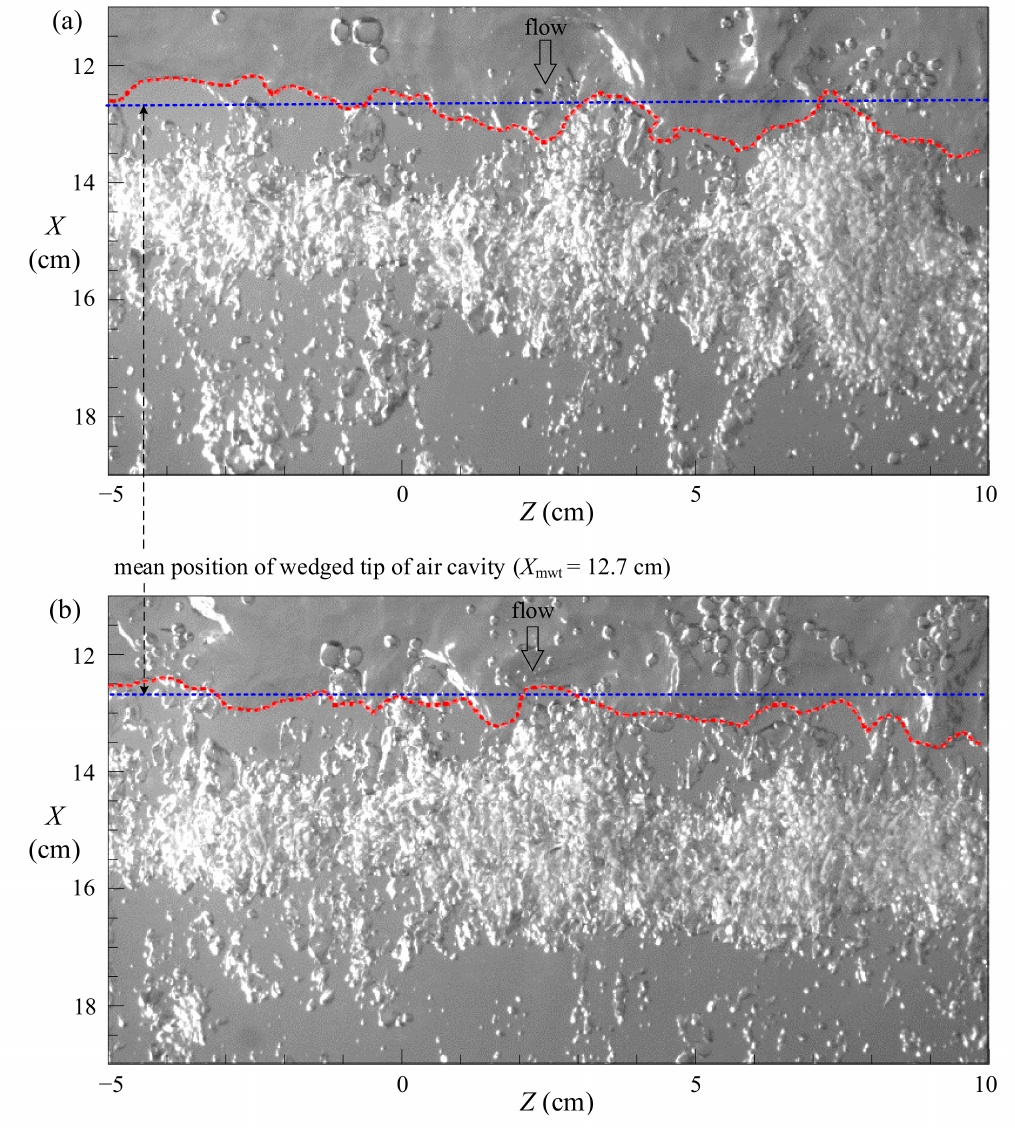
Figure 8. Two snapshots showing wavy variation in the instantaneous position of the wedged tip of air cavity (marked in red curve) in the spanwise direction, together with indication of the mean location (beveled with blue dashed